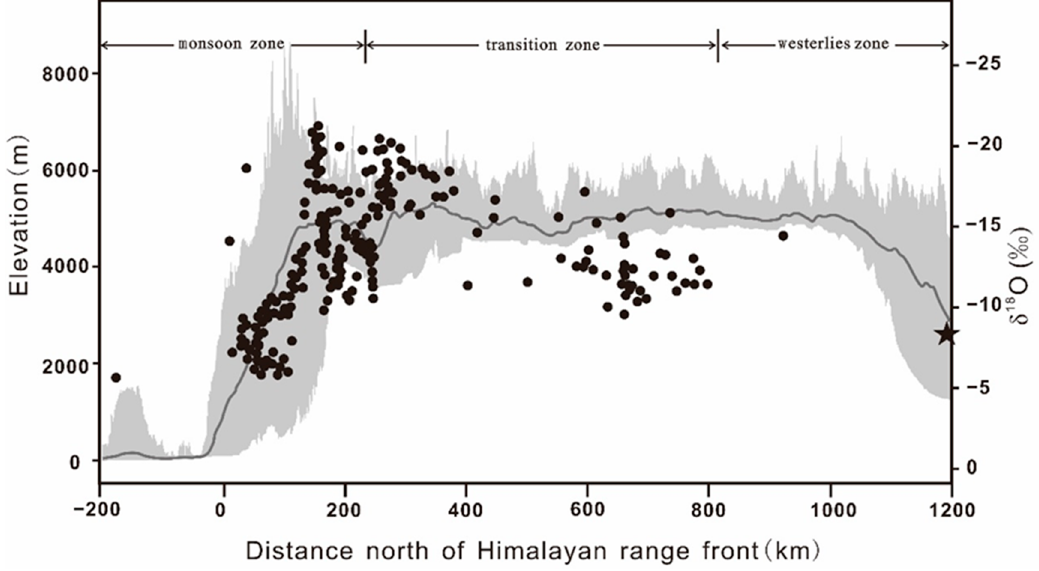
Figure 6. Topographic swath profiles (left y-axis) and meteoric water δ 18 O values (right y-axis) plotted as a function of distance from the major regional orographic barrier for the Himalayan–Tibetan Plateau orogen. Upper and lower bounds of the gray swath mark the maximum and minimum elevations, respectively. Dark-gray lines mark mean elevation. Solid circles indicate δ 18 O values, the star indicates the precipitation-weighted annual mean δ 18 O in the upper reaches of the Heihe River Basin (compiled from Lechler et al. [1]).